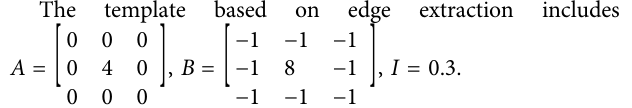
Frontiers in Physics |